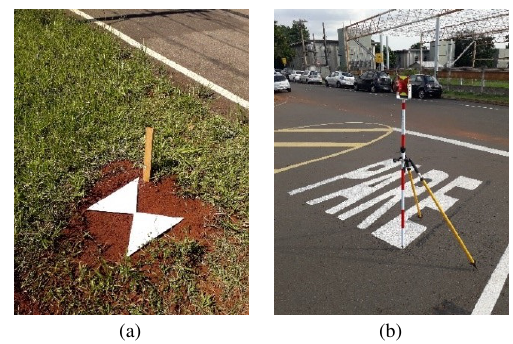
Figure 3. GCP and Check-point. a) Target using white paper sheet; b) Signing and pavement marking.